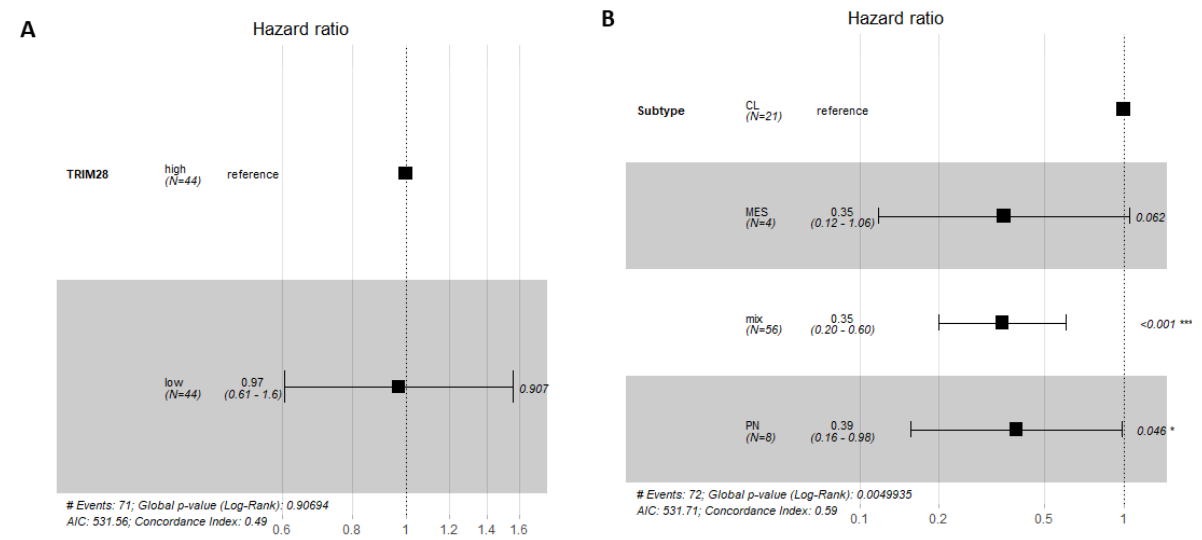
Figure 3. TRIM28 is not a prognostic marker of GB patient survival. Forest plot for Cox proportional hazards model showing the association between TRIM28 expression levels in GB and GB subtypes and survival, with confidence interval of 95% CI. ( A ) TRIM28 high or low expression, within GB group ( n = 88). ( B ) TRIM28 high or low expression, within CL, PN, MES and MIX GB subtypes, has no effect on prognosis of GB patient survival. CL GB subtype is set as a reference. * p < 0.05, *** p < 0.001.